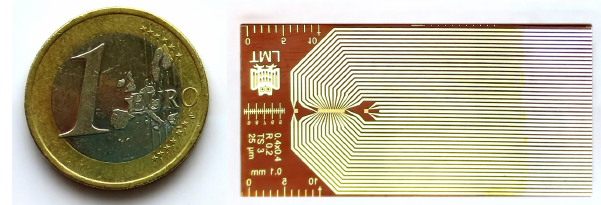
Figure 5. Photograph of sensor chip realized on polyimide foil (Schmitt et al., 2013b).